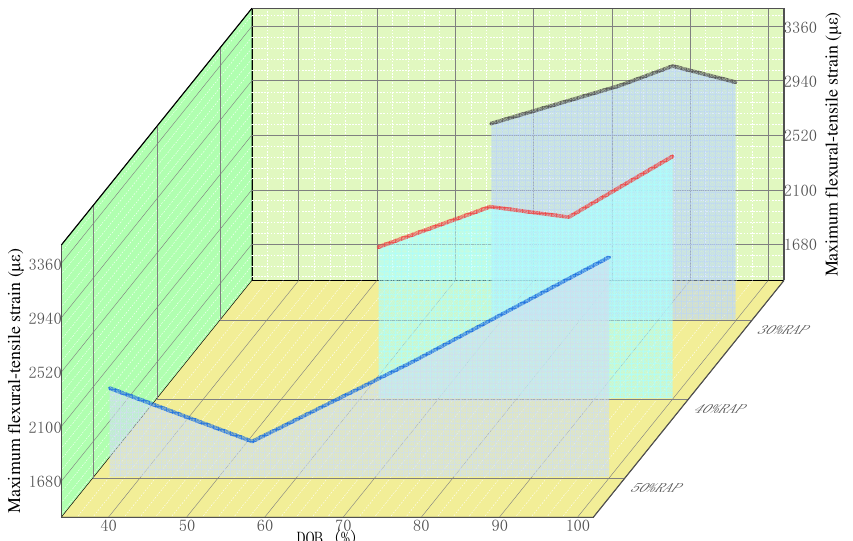
Figure 4. Variation of maximum flexural–tensile strain with the variation of DOB under different RAP contents.